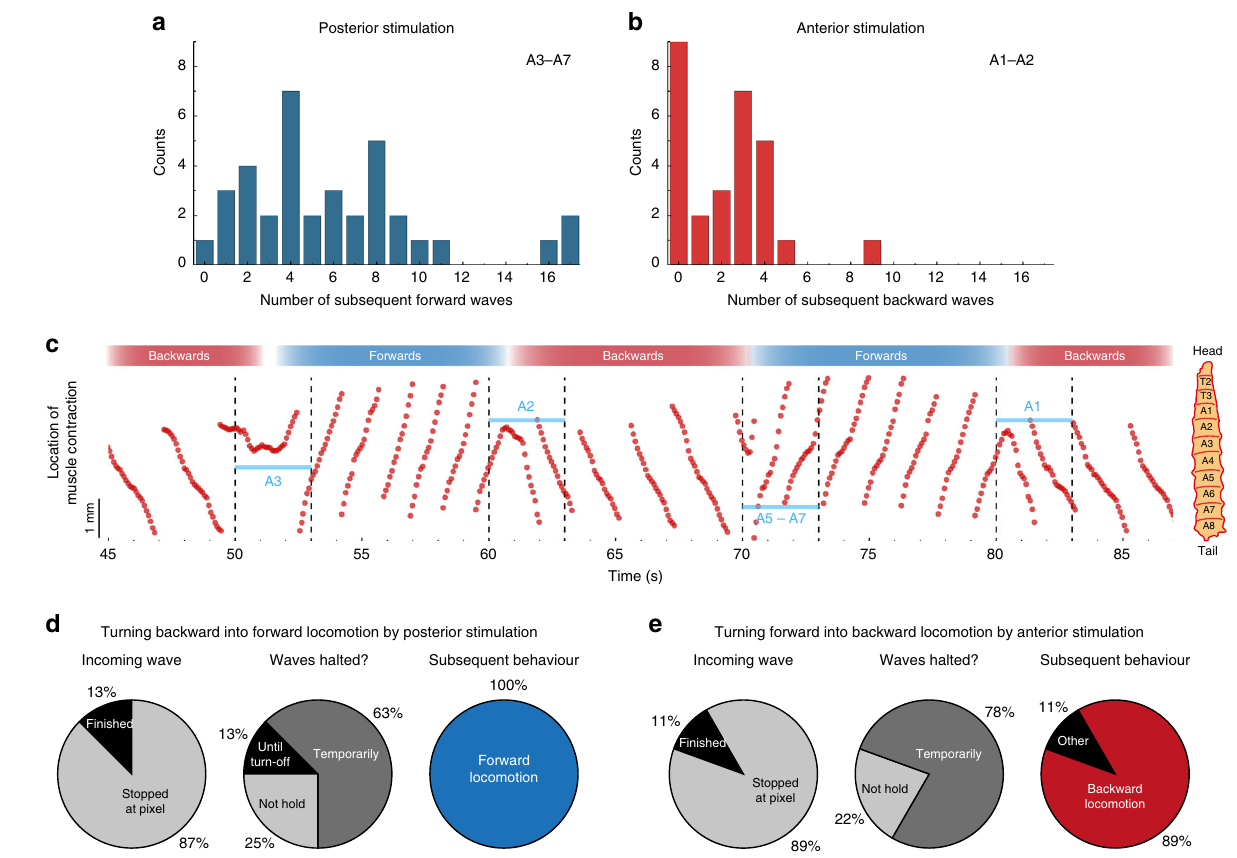
Fig. 6 Switching locomotion direction in 5 – 40-GAL4 > CsChrimson larvae by targeted local stimulation. a Histogram of the number of subsequent forward crawls within a detection window of 30 s after stimulation in segments A3 – A7 for 3 s. n = 10 larvae, 36 stimulations. b Same as a for backward waves after anterior stimulation. n = 14 larvae, 28 stimulations. c Representative trace of the location of a muscle contraction wave over time (Supplementary Movie 5). Every 10 s, the larva was stimulated for 3 s, alternating between stimulation in more anterior or more posterior regions. The illuminated segment is indicated in blue. d , e Statistics of switching behaviour for d posterior stimulation ( n = 3 larvae, eight stimulations) and e anterior stimulation ( n = 5 larvae, nine stimulations). Light intensity: 15 µ W mm − 2